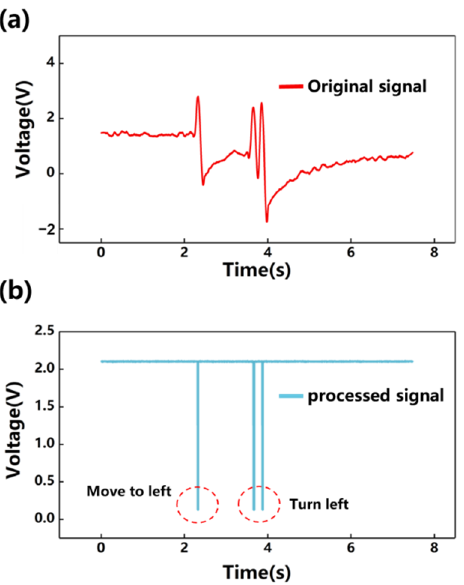
Figure A4. Transferred signal of the RWTP: ( a ) original signal and ( b ) processed signal.